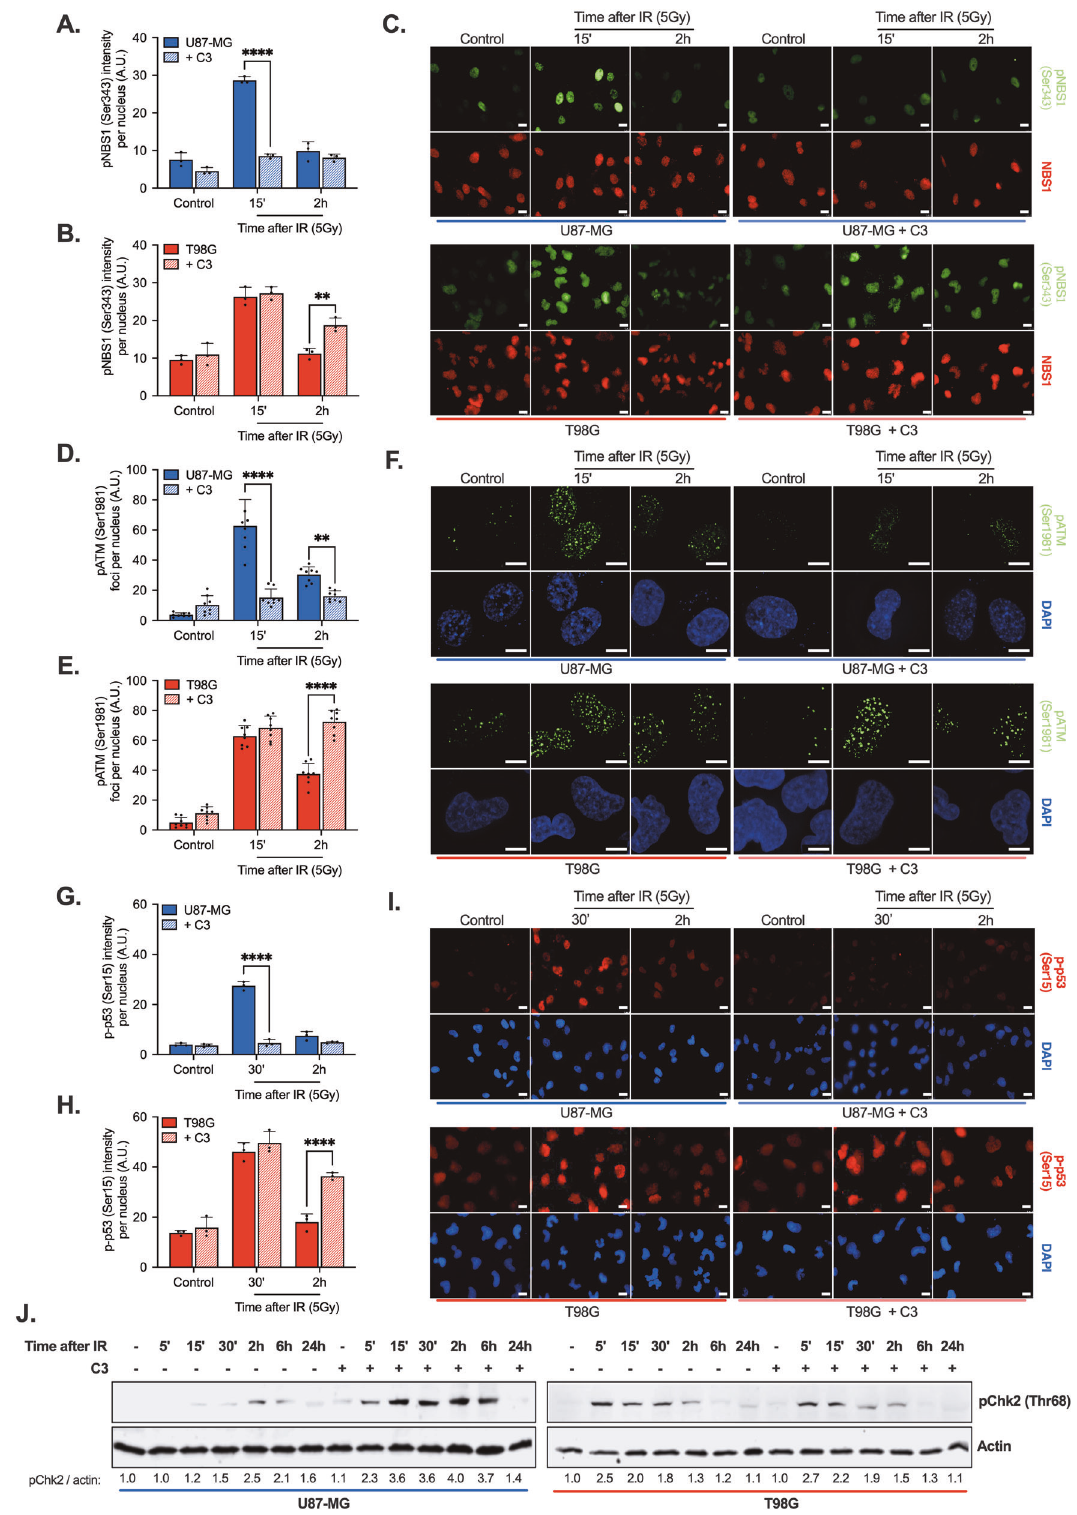
viable DR-GFP U87-MG clones were isolated. Analysis of pBRCA1 foci in response to IR as an early indicator of HR showed that treatment with C3 toxin almost completely abolished both the recruitment of pBRAC1 to DSB sites and the phosphorylation of Cell Death and Disease (2023)